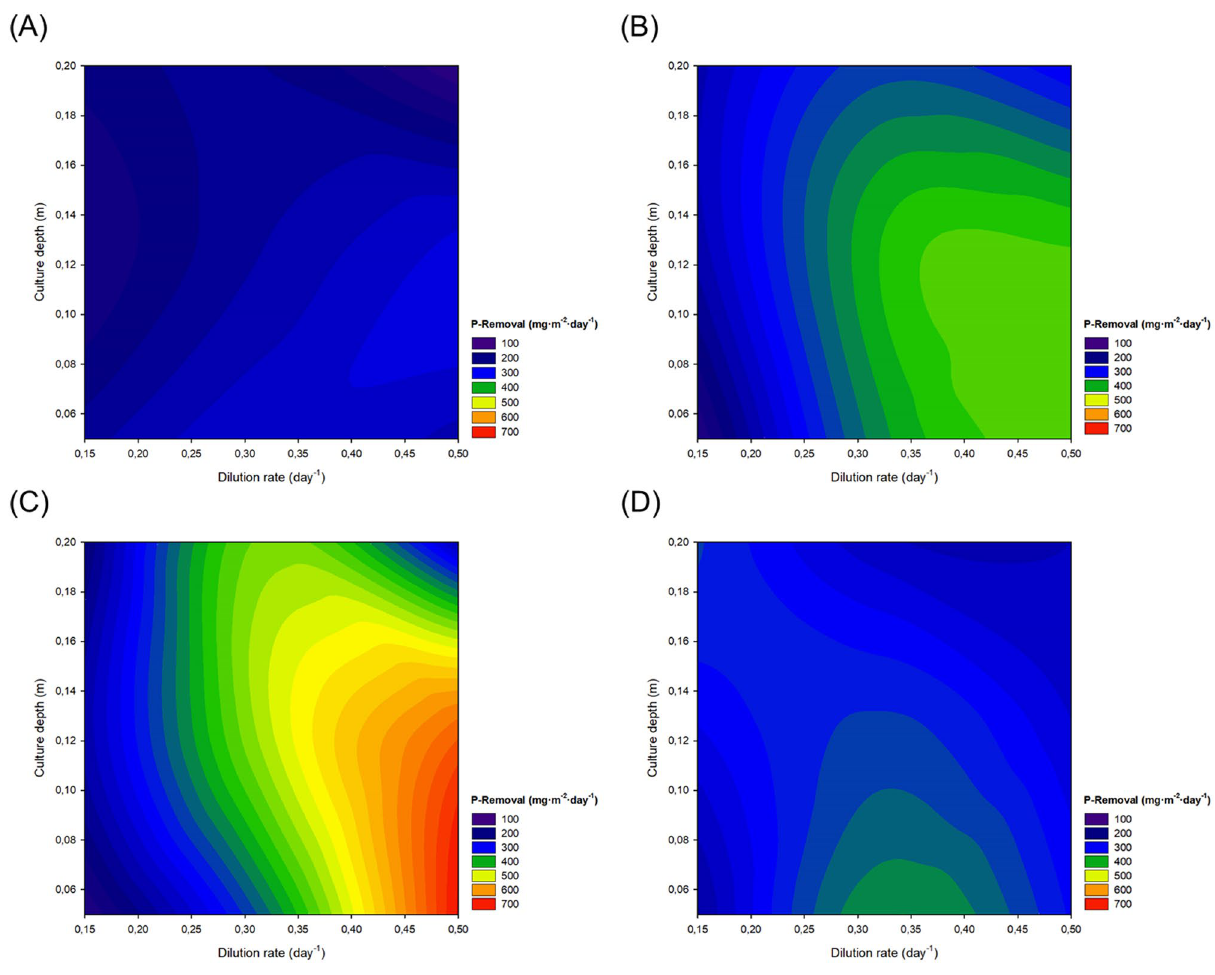
Figure 5. 2D contour plot of P-PO 4 3− removal capacity of the reactors in (A) winter, (B) spring, (C) summer, and (D) autumn . Figure made using SigmaPlot v11.0 (Systat Software Inc., CA,